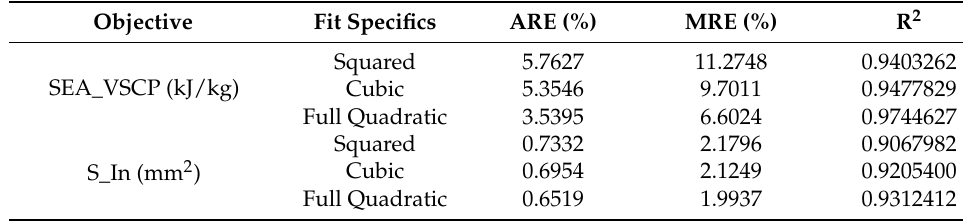
Table 6. Error analysis of the RS